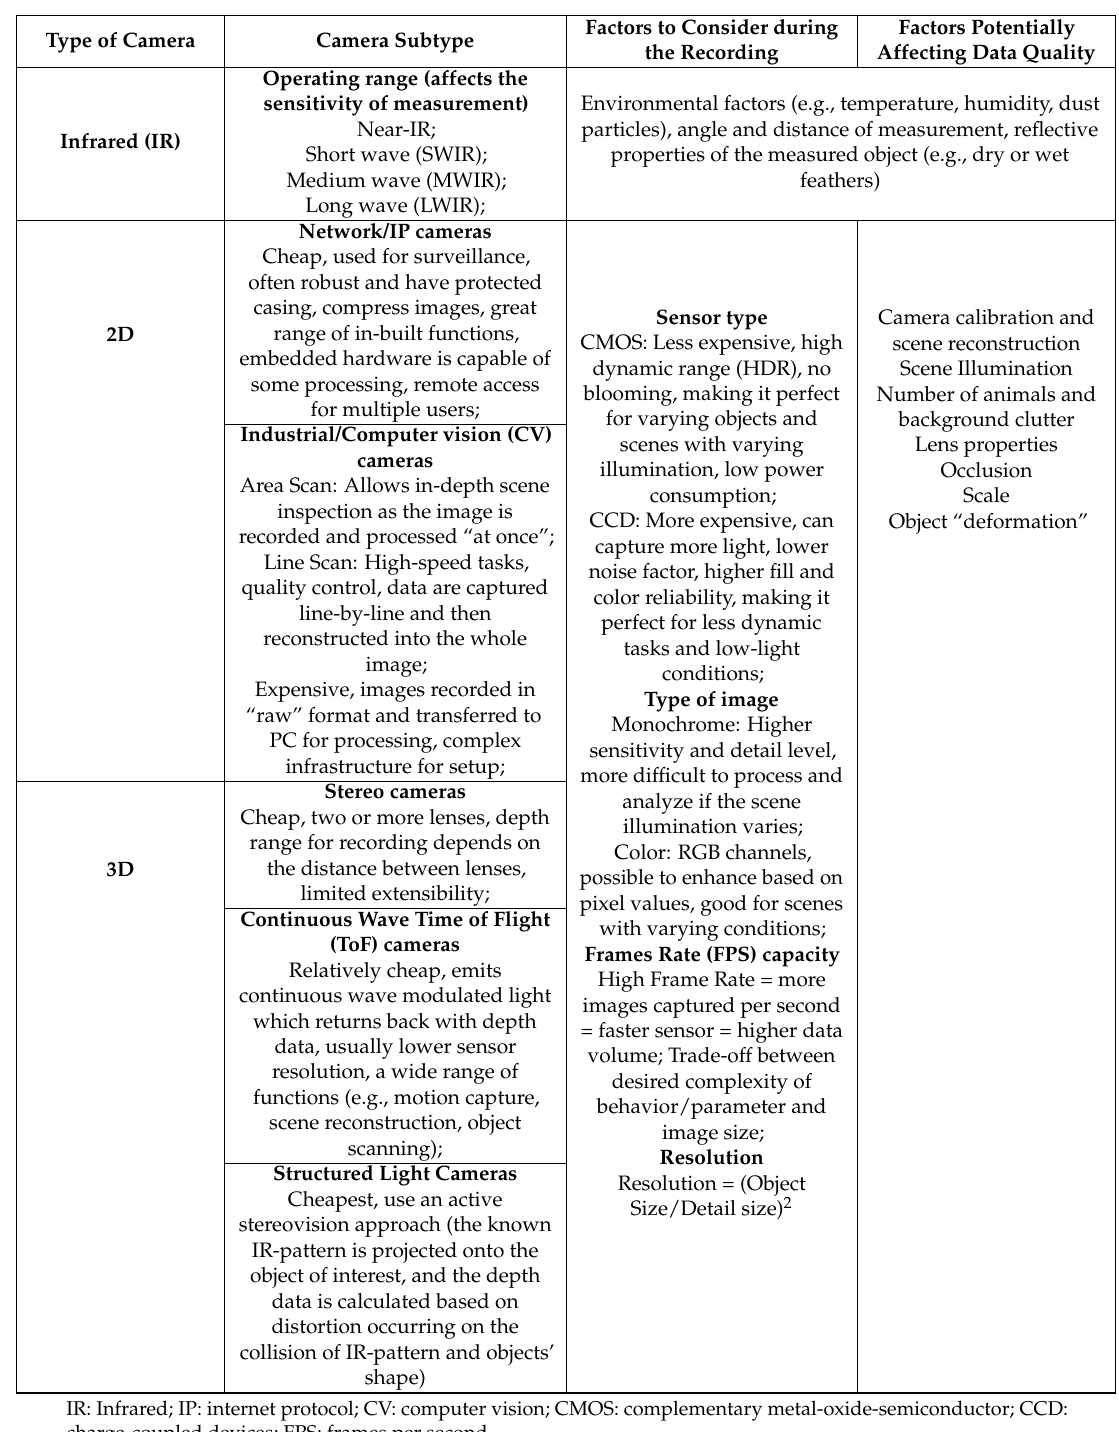
Table 1. Image acquisition layout and an overview of the different challenges using different types of